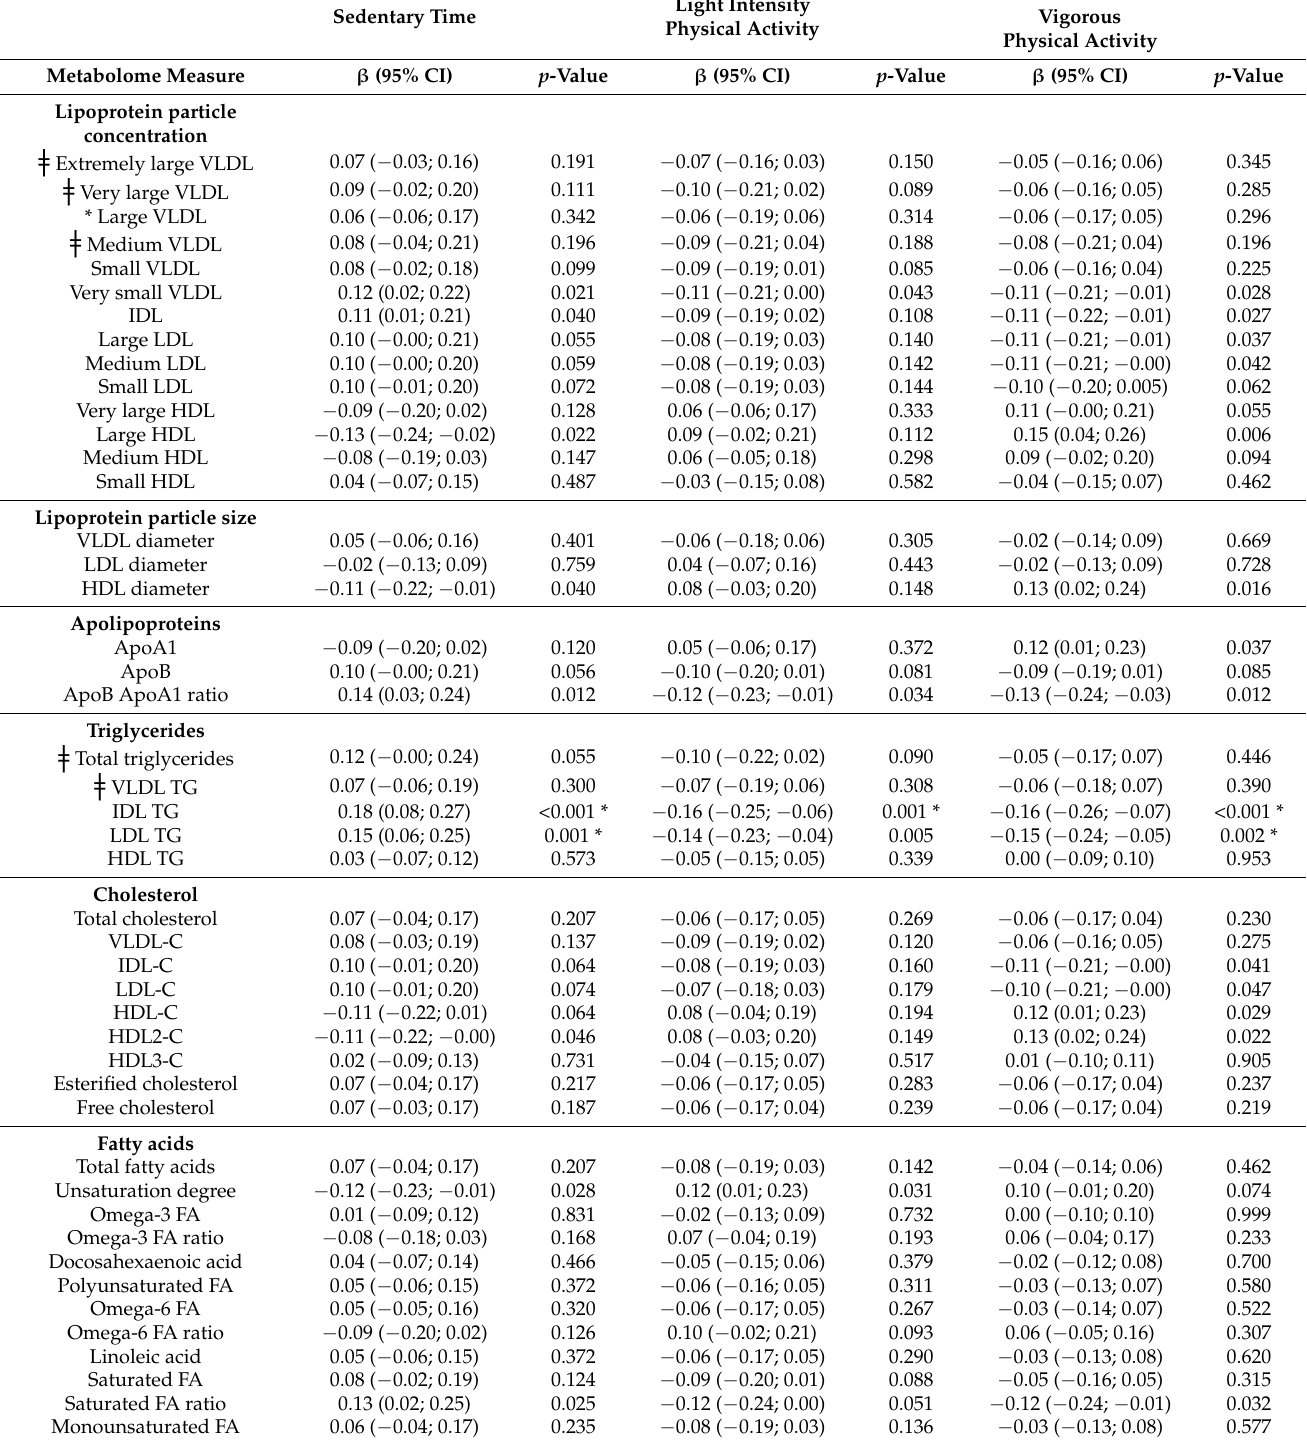
Table 2. Standardized single regression coefficients ( β ) of sedentary time and physical activity intensities with their 95% confidence intervals (CI) from age, education, smoking, alcohol, and nutrition-adjusted linear regression models for serum metabolome. Bonferroni-corrected p -value of ≤ 0.002 was set as the level for statistical significance, which corresponds to a p -value of less than